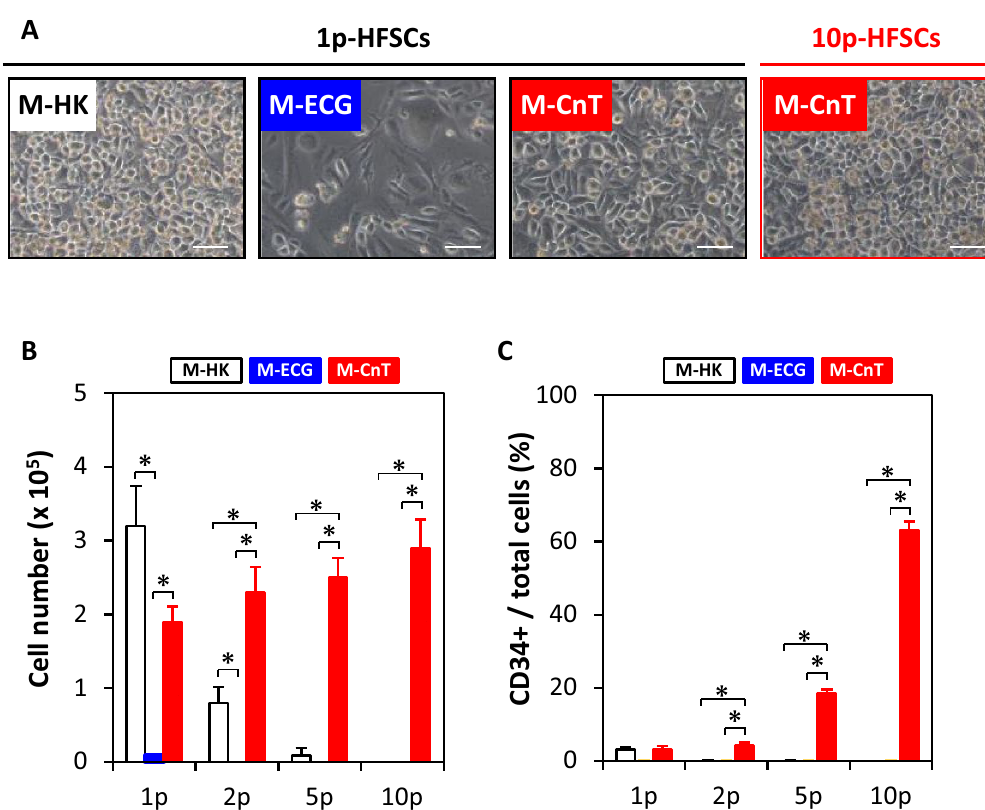
Figure 2. Characterization of HFSCs cultured in various medium types for short term. ( A ) Morphology results of primary HFSCs (1p-HFSCs) cultured with M-HK, M-ECG, or M-CnT for seven days. 10p-HFSCs denotes the morphology of HFSCs after 10 passages when cultured with M-CnT for 7 days. Scale bar = 50 mm. ( B ) Cell proliferation of HFSCs cultured with various types of medium (M-HK, M-ECG, M-CnT) for a short term (1p- to 10p-HFSCs). Assays of 2p-, 5p-, or 10p-HFSCs cultured with M-ECG, or 10p-HFSCs cultured with M-HK were not performed. * p < 0.05 ( C ) CD34-immunopositivity of HFSCs cultured with various types of medium (M-HK, M-ECG, M-CnT) for a short term (1p- to 10p-HFSCs). Assays of 2p-, 5p-, or 10p-HFSCs cultured with M-ECG, or 10p-HFSC cultured with M-HK were not performed. CD34-immunpositive cells were not detectable in 1p-HFSCs cultured with M-ECG, or 2p- and 5p-HFSCs cultured with M-HK. * p <